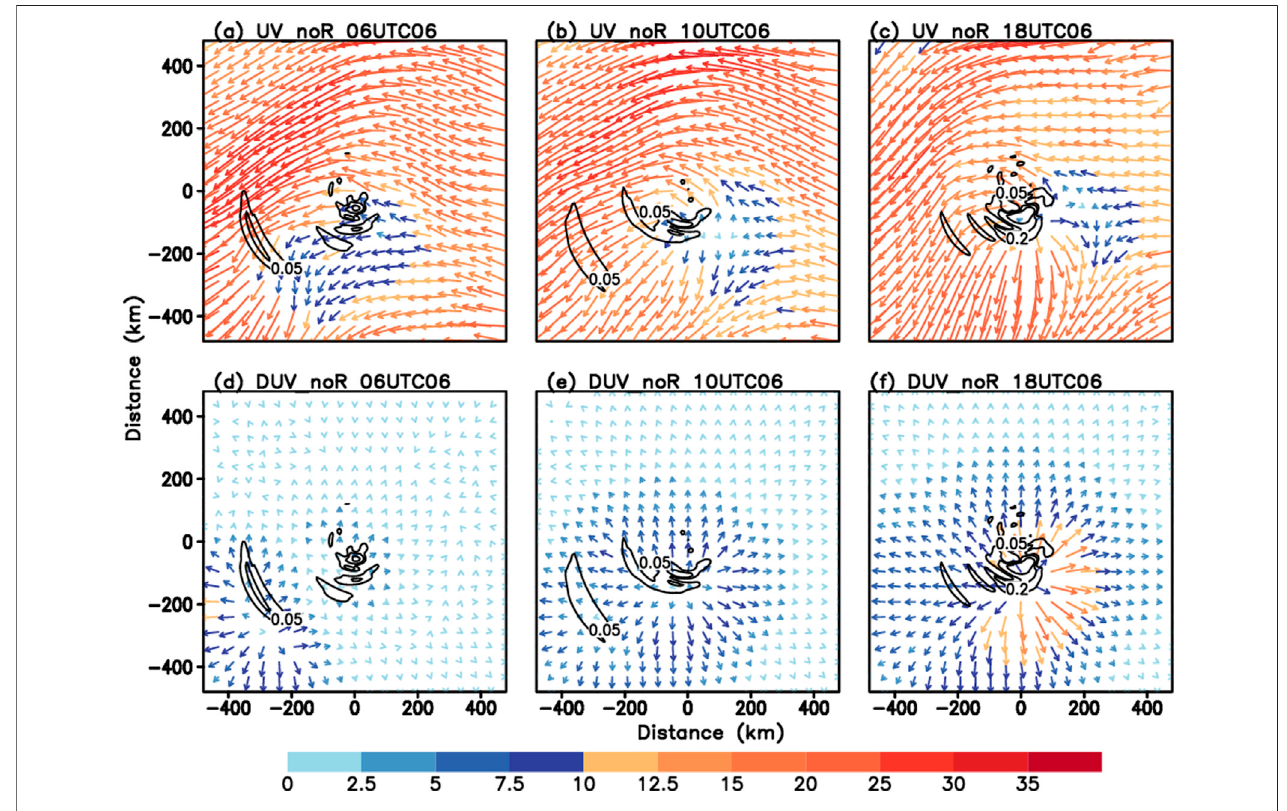
FIGURE 9 | As in Figure 8 , but in